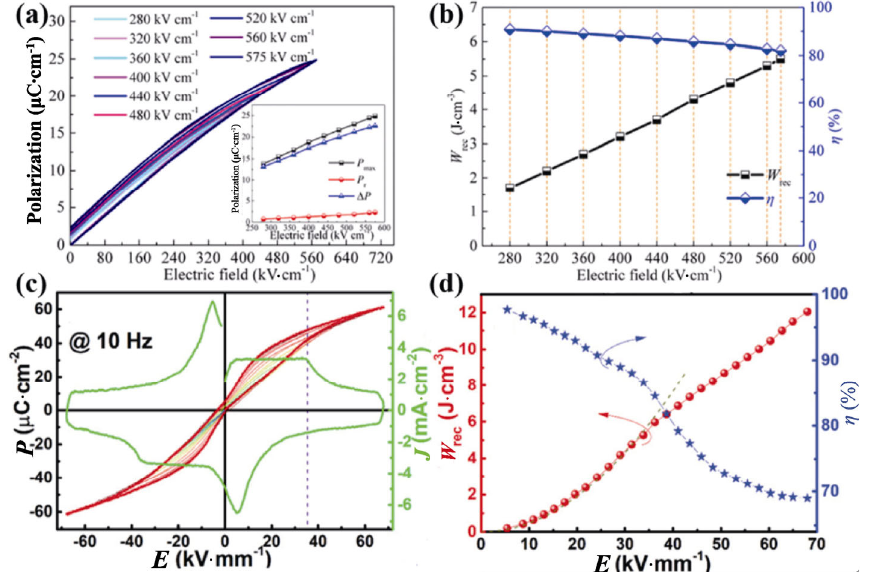
Fig. 14 (a) P – E loops and (b) energy-storage properties of 0.85NN–0.15BNT ceramic at room temperature. Reproduced